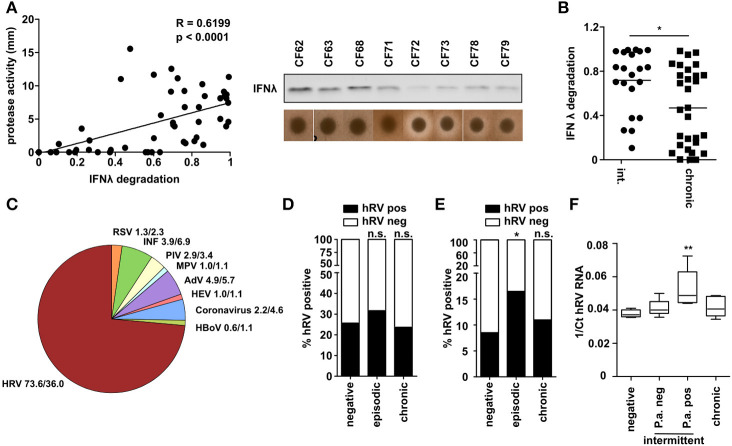
CF patients with intermittent P. aeruginosa infection are at higher risk to be infected with hRV. (A) Capacity of CF P. aeruginosa isolates to degrade IFNλ was analyzed by western blot and protease activity was measured by skim milk agar. Correlation was assessed using Spearman analysis (n = 51). (B)
P. aeruginosa isolates from (A) were classified according to infection status and plotted against relative IFNλ degradation after 1 h. Statistical analysis was done using non-parametric Mann-Whitney test. (C) Presence of respiratory viruses in sputum samples of CF patients were assessed using a multiplex diagnostic virus panel assay. Relative occurrence of respiratory virus positive samples and total samples are indicated (n = 340). (D) The prevalence of hRV in CF samples (nose, throat and sputum) was plotted according to the infection status (n = 340). Statistics was done by using Fisher's Exact Test. (E) The prevalence of hRV in CF sputum samples was plotted according to the infection status (n = 499). Statistics was done by using Fisher's Exact Test. (F) Presence of hRV in sputum from CF patients was assessed by qPCR. The Ct values of hRV was plotted according to the infection status (n = 24). Significant differences were considered at *p < 0.05, **p < 0.01, and ***p < 0.001 as compared to the control condition. n.s., not significant.